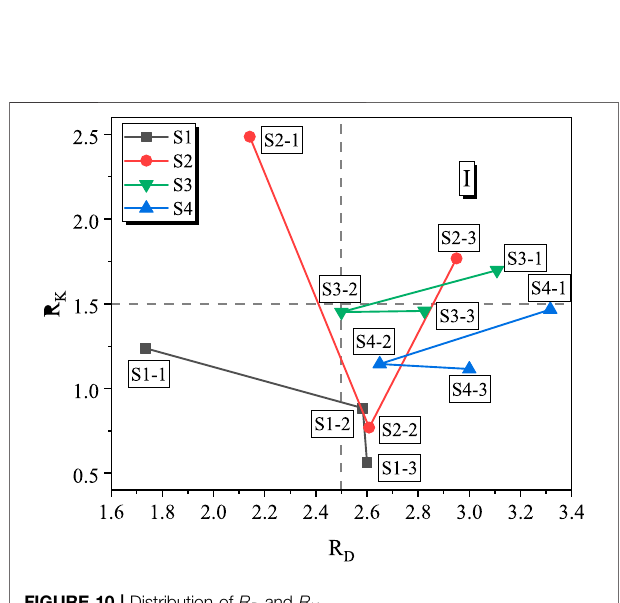
FIGURE 10 | Distribution of R D and R K .